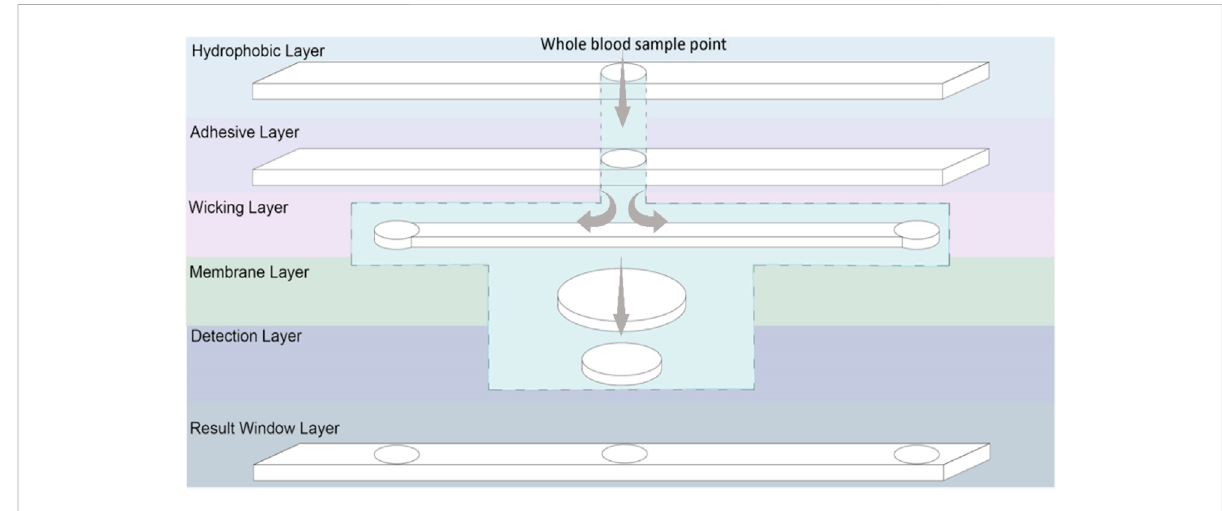
FIGURE 6 Schematic representation of a laminated glucose diagnostic representing the Micro fl uidic 3D pathway of the handheld device.